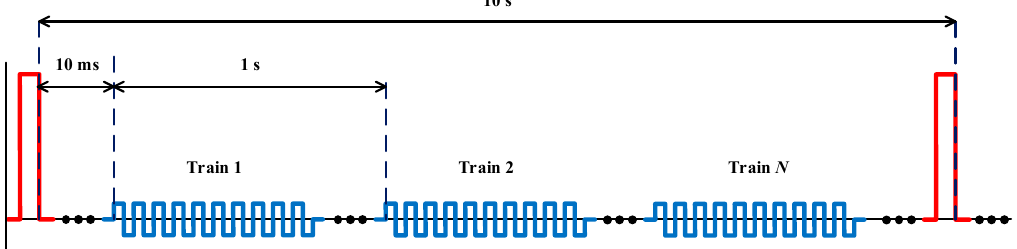
Figure 1. Voltage waveforms used in the experiments including large- and small-signal waveforms.